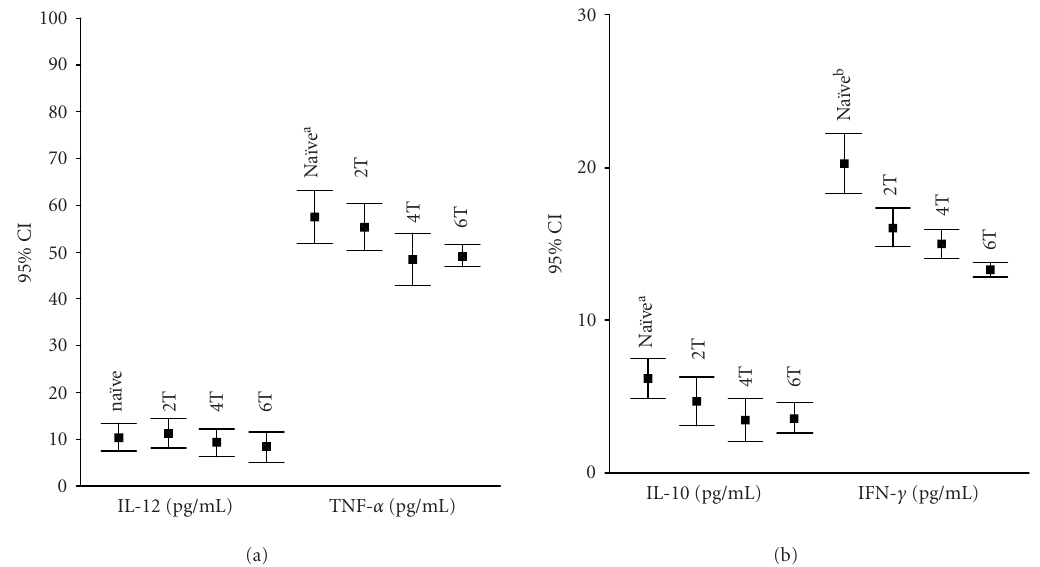
Figure 1. The mean serum levels of (a) IL-12 and TNF- α and (b) IL-10 and IFN- γ in APTB patients ( n = 20). Na¨ıve: patients who had not received ATT. 2T: patients who received ATT for two months. 4T: patients who received ATT for four months. 6T: patients who received ATT for six months. a Significantly di ff erent compared with 4T ( P = . 034 for TNF- α , P = . 018 for IL-10) and 6T ( P = . 004 for TNF- α , P = . 000 for IL-10) patients. b Significantly di ff erent compared with 2T ( P = . 008), 4T ( P = . 000), and 6T ( P = . 001).